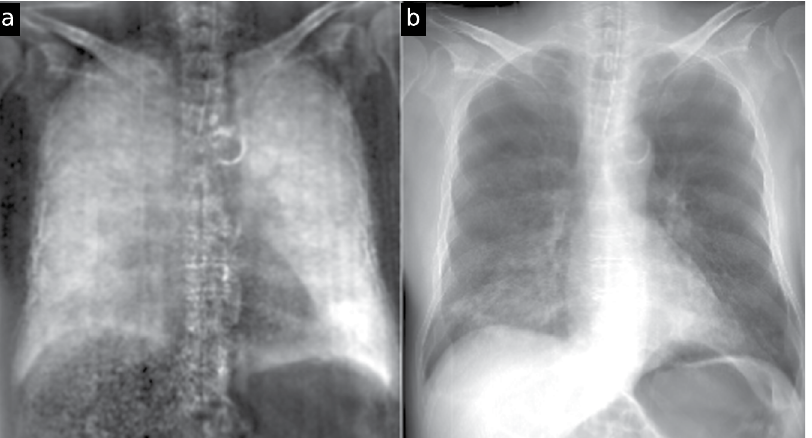
Figure 1. X-ray dark-field ( a ) and transmission ( b ) radiograph of a human thorax at 60kVp. The dark-field image was low-pass filtered by convolution with a 2D Gaussian kernel ( σ = 3.2 px). In the transmission image, an infiltrate is visible in the lower left lung, which translates to a lower dark-field signal in this zone. Of all examined tube voltages (see also Fig. 2), the highest dark-field signal strength can be found at 60